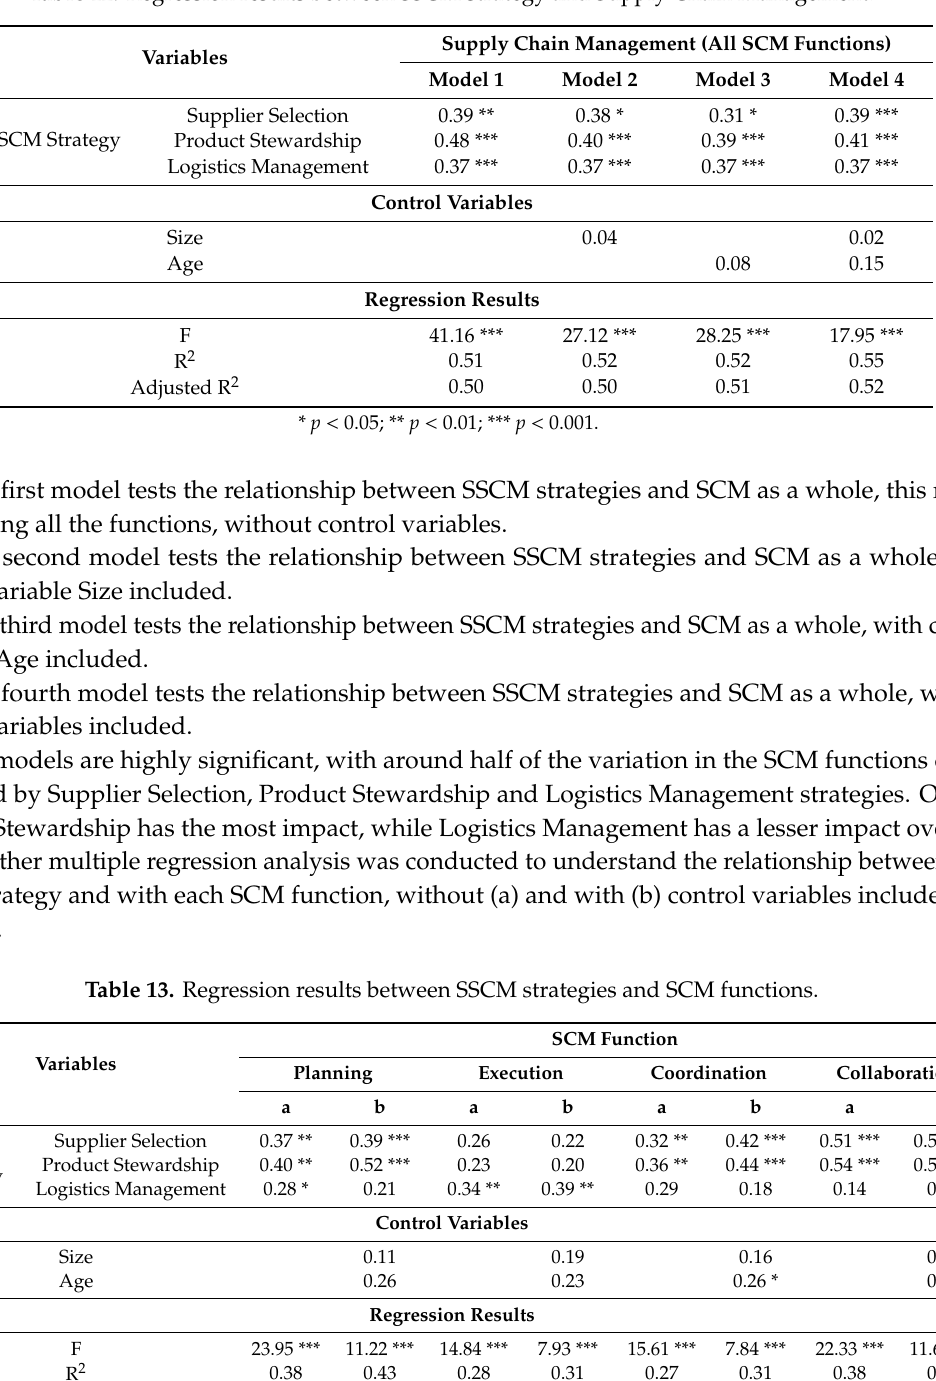
Table 12. Regression results between SSCM strategy and Supply Chain Management.